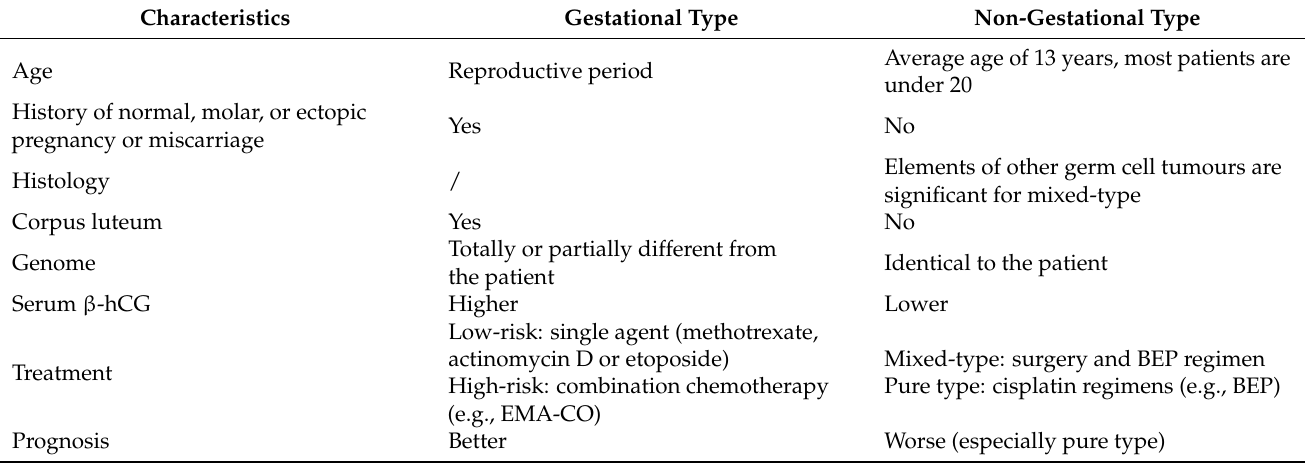
Table 1. Differences in gestational and non-gestational choriocarcinoma [9,13,14]. Characteristics Gestational Type Non-Gestational